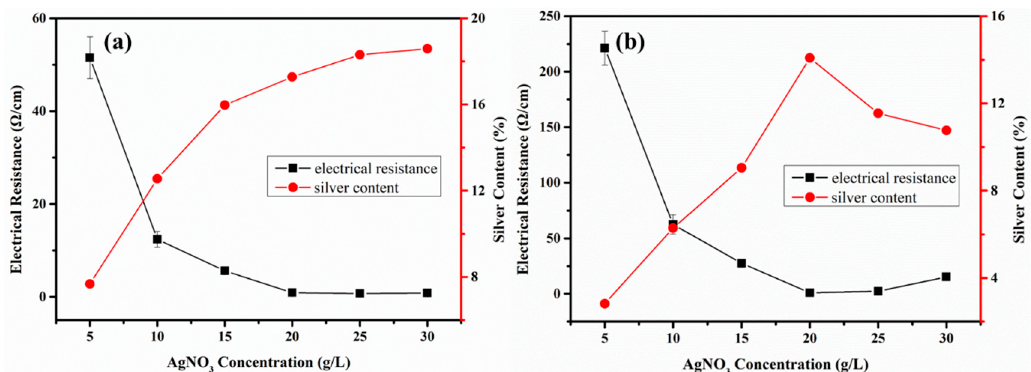
Figure 12. The relationship between the electrical resistance and silver content of plasma-treated PPTA fibers before ( a ) and after ( b ) 10 washing cycles and the AgNO 3 concentration.